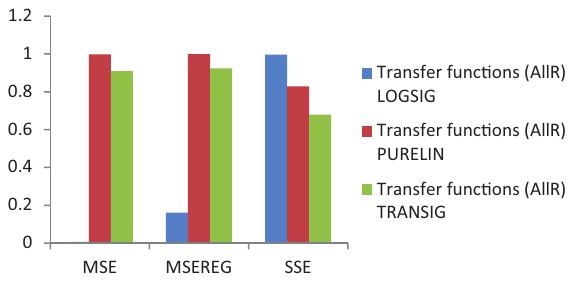
Figure 11. Results for various Transfer functions for all R Table 5. Results for various Transfer functions for validation R Performance function